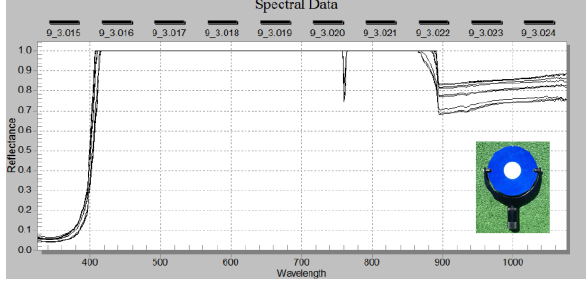
Figure 4: Reflectance chart of